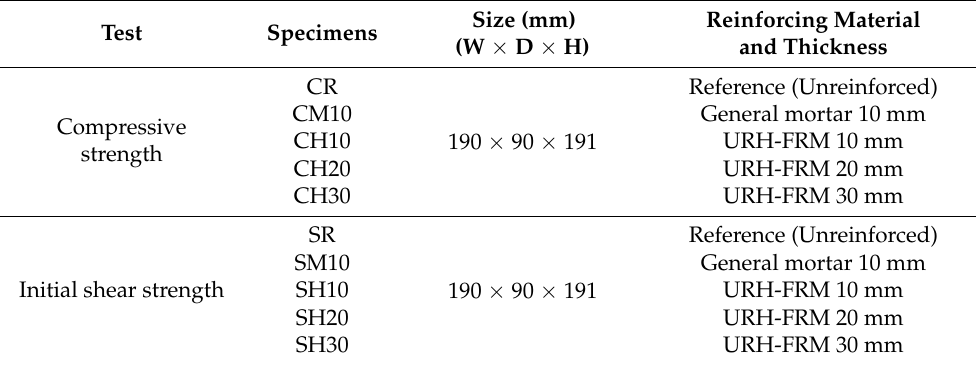
Table 3. Experimental variables.